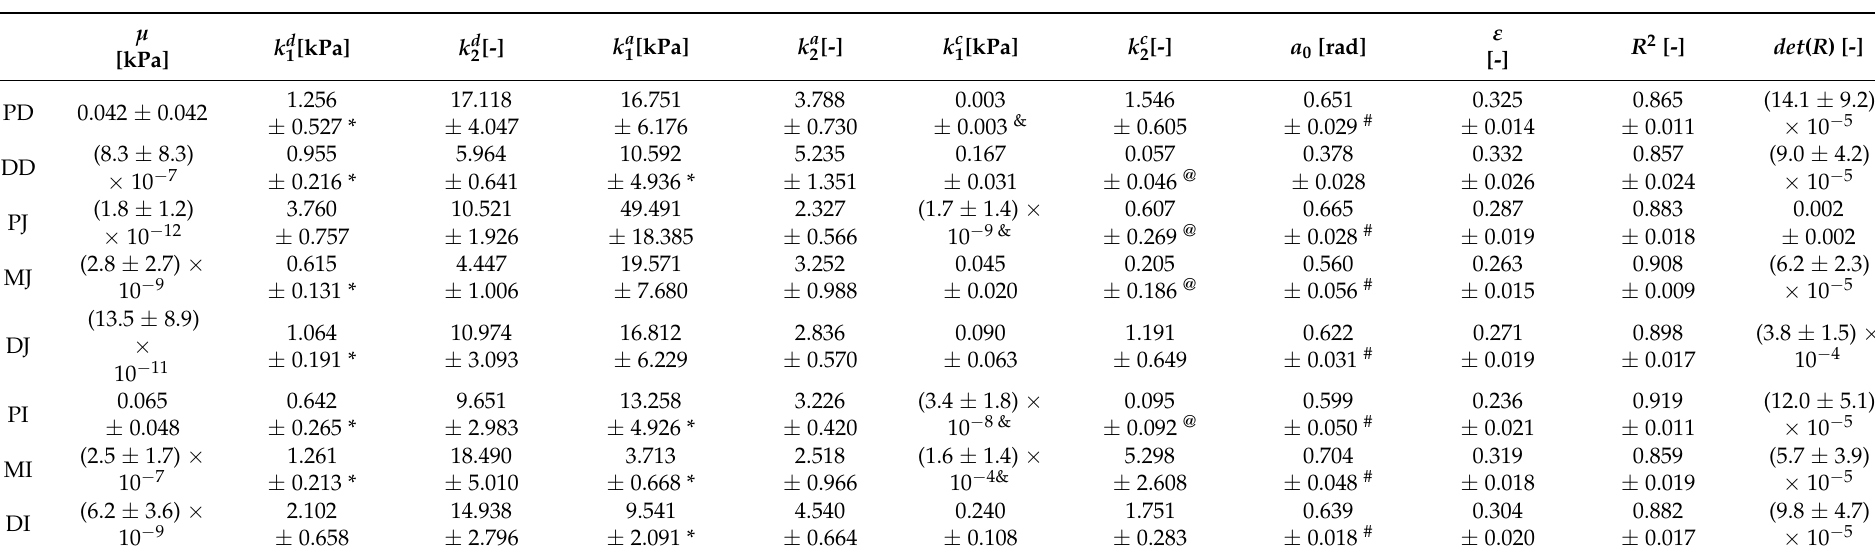
Table 1. Parameters of the neo-Hookean and four-fiber family model fitted to experimental data of eight small intestinal